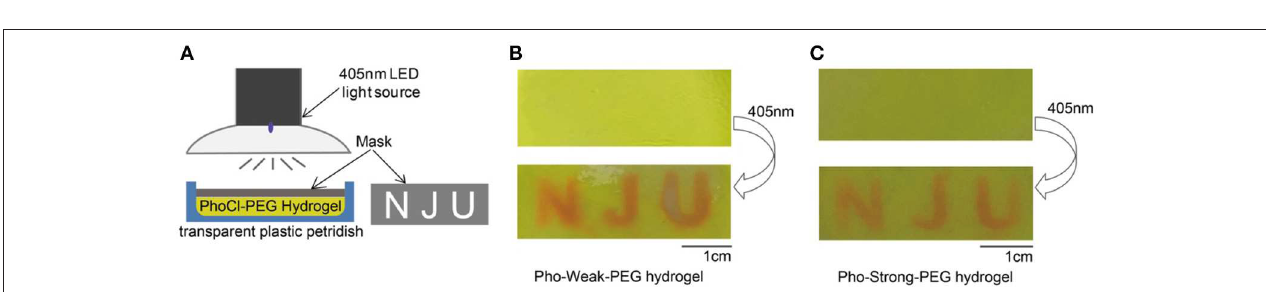
FIGURE 6 | Spatially Control the Mechanical Properties of PhoCl-PEG hydrogels. (A) Schematic diagram of the experiment. (B) The letters of “NJU” were printed on a Pho-Weak-PEG hydrogel by photo illumination at 405nm for 40min through a mask. (C) The letters of “NJU” were printed on a Pho-Strong-PEG hydrogel by photo illumination at 405nm for 40min through the same